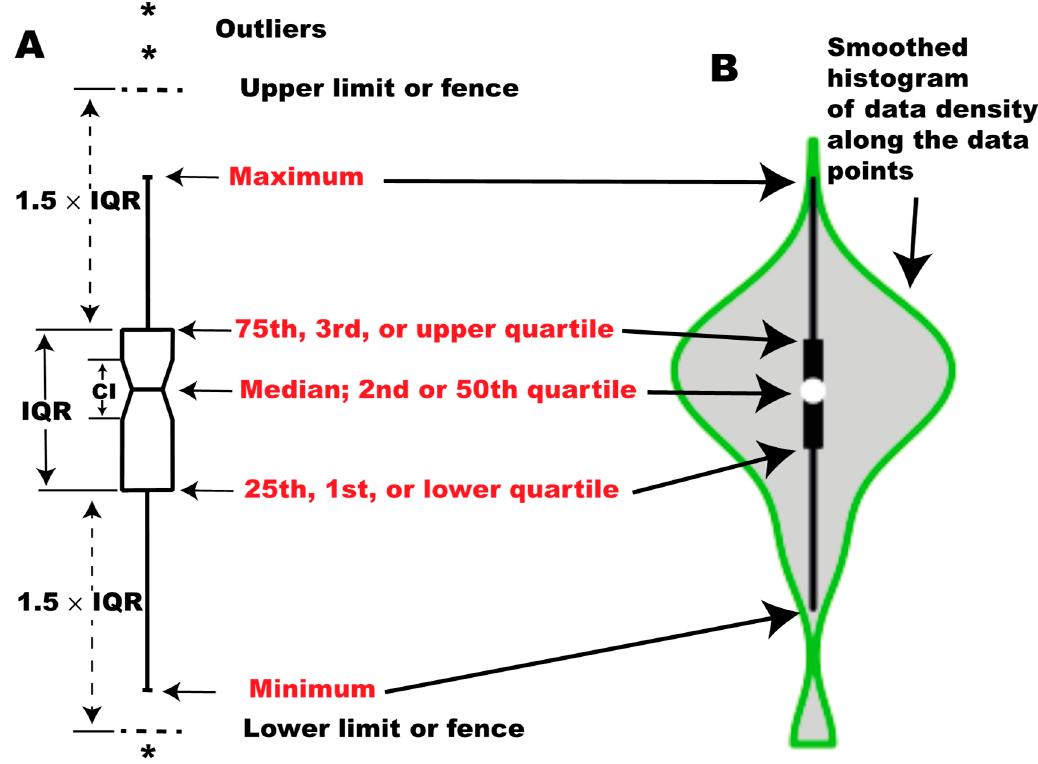
Figure 1. Configuration of boxplots. ( A ) conventional box plot; ( B ) violin plot.